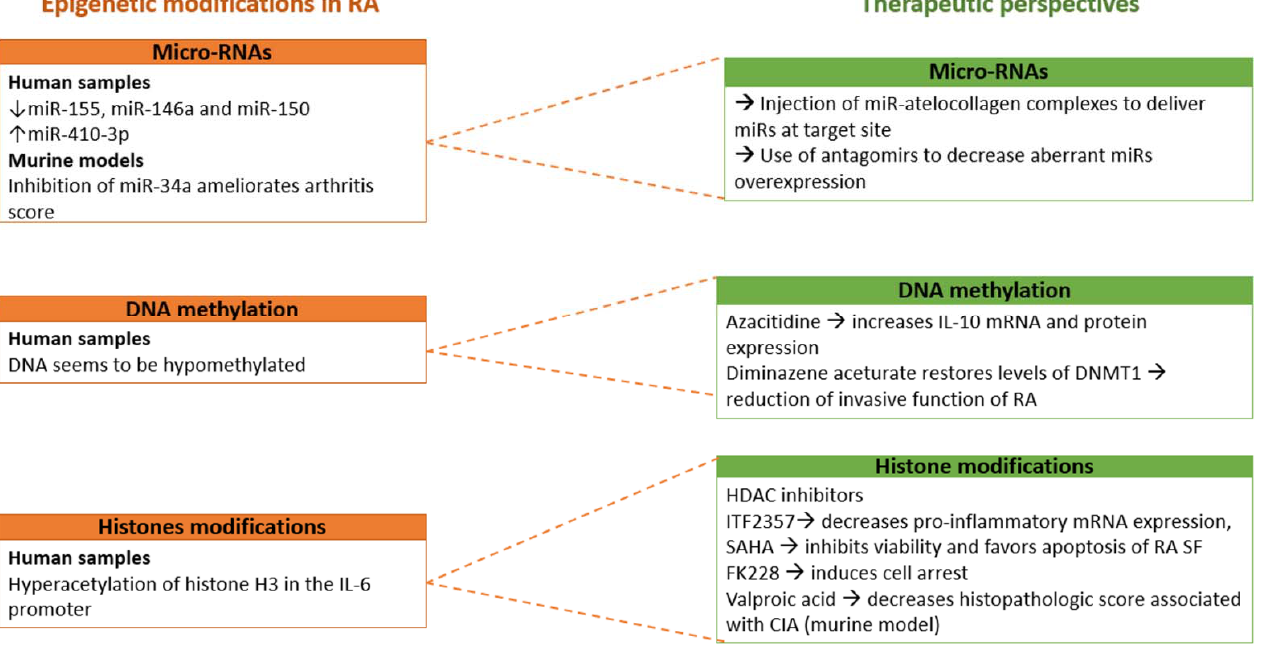
Figure S3: Forest plot of the meta-analysis for the expressions of miR-17 and miR-124a in human samples, Figure S4: Forest plot of the meta-analysis for the effect of miR-155 on IL-6 and MMP-3 in human samples, Figure S5: Forest plot of the meta-analysis for the effect of miR-155 on IL-6 and MMP-3 in human